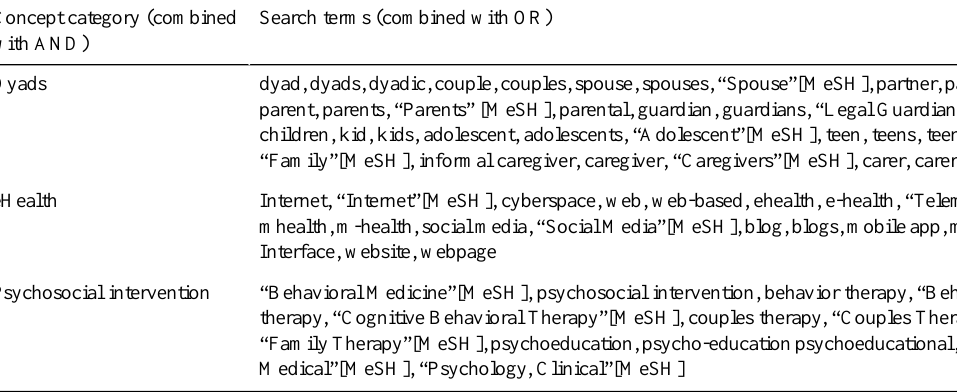
Search terms (combined with OR)Concept category (combined